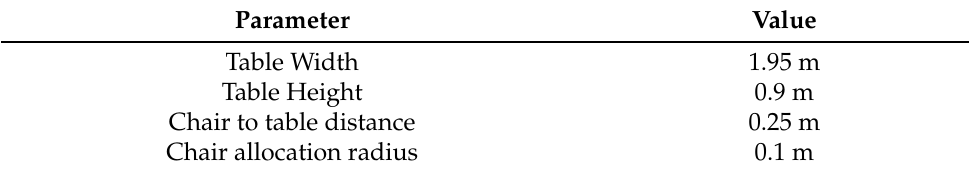
Table 1. Parameters and Measurements obtained empirically from the analysed